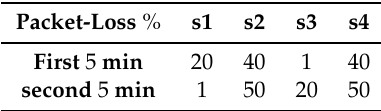
Table 5. Emulated packet-loss percentages for Scenario-2.